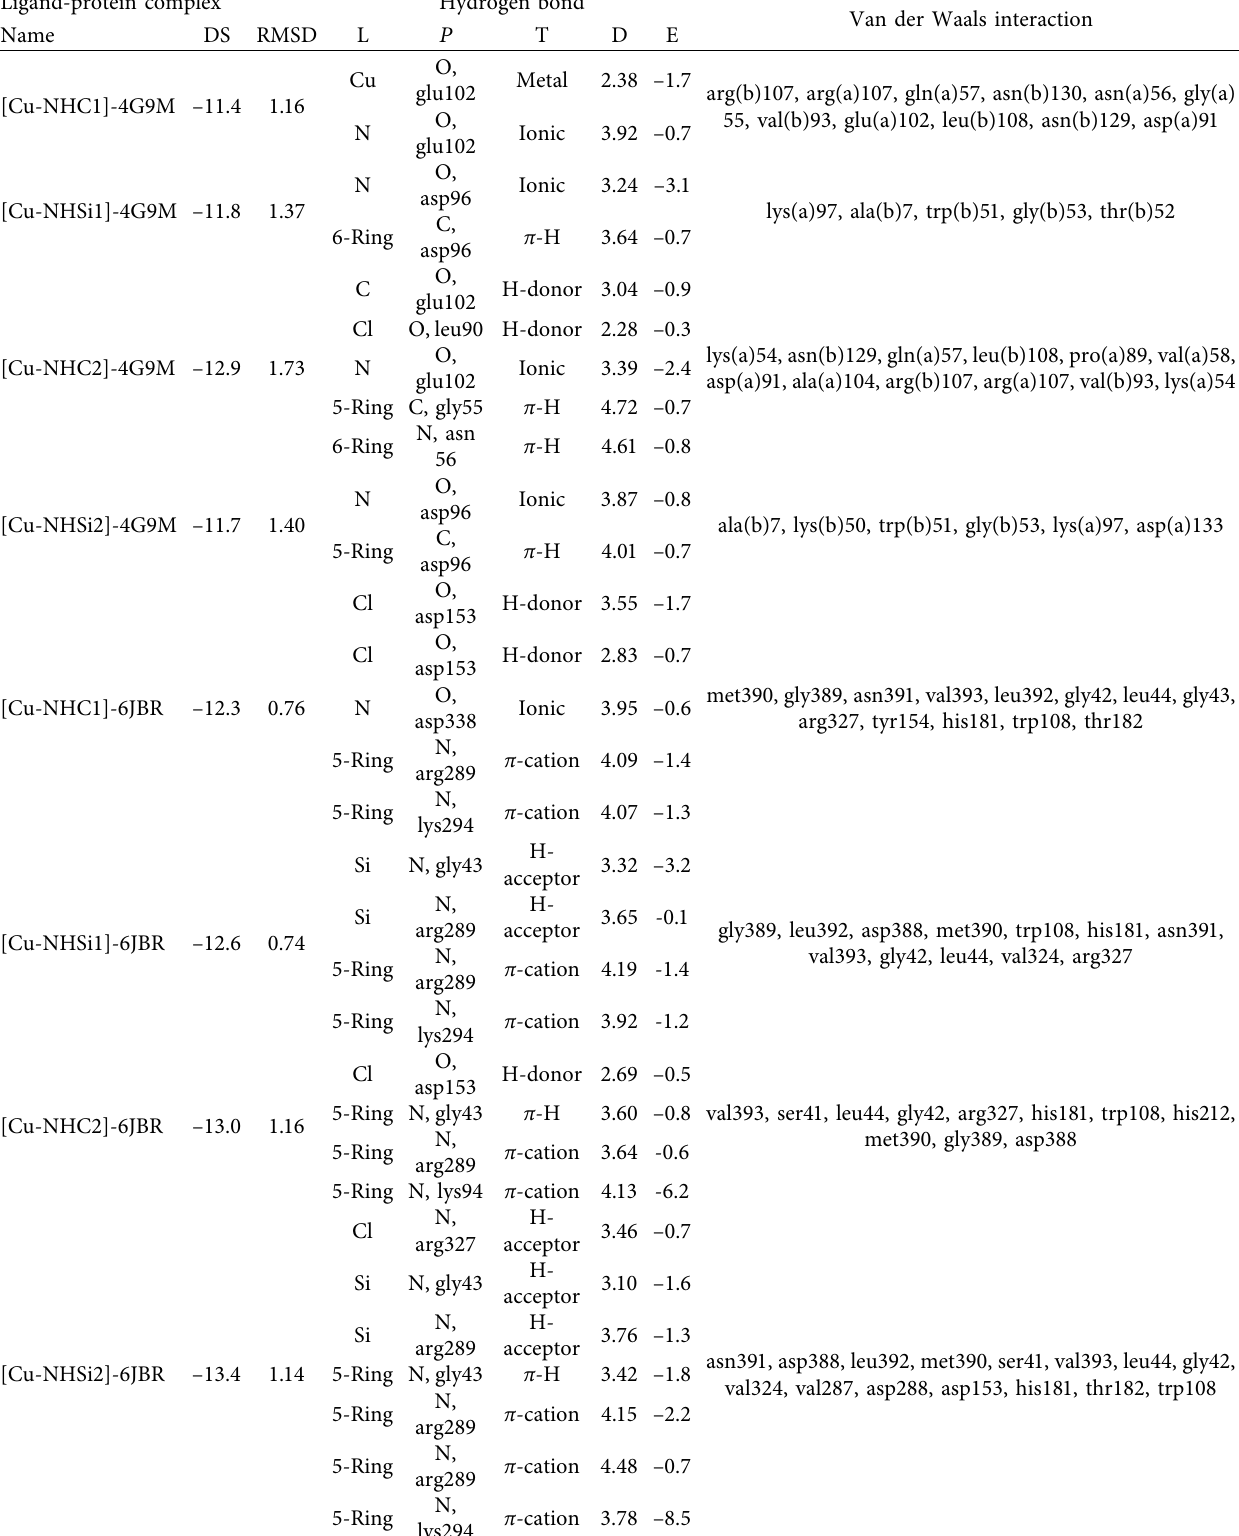
Table 5: Molecular docking simulation results for ligand-protein inhibitory structures: [Cu-NHC1]-4G9M, [Cu-NHSi1]-4G9M, [Cu- NHC2]-4G9M, [Cu-NHSi2]-4G9M, [Cu-NHC1]-6JBR, [Cu-NHSi1]-6JBR, [Cu-NHC2]-6JBR, and [Cu-NHSi2]-6JBR. Ligand-protein